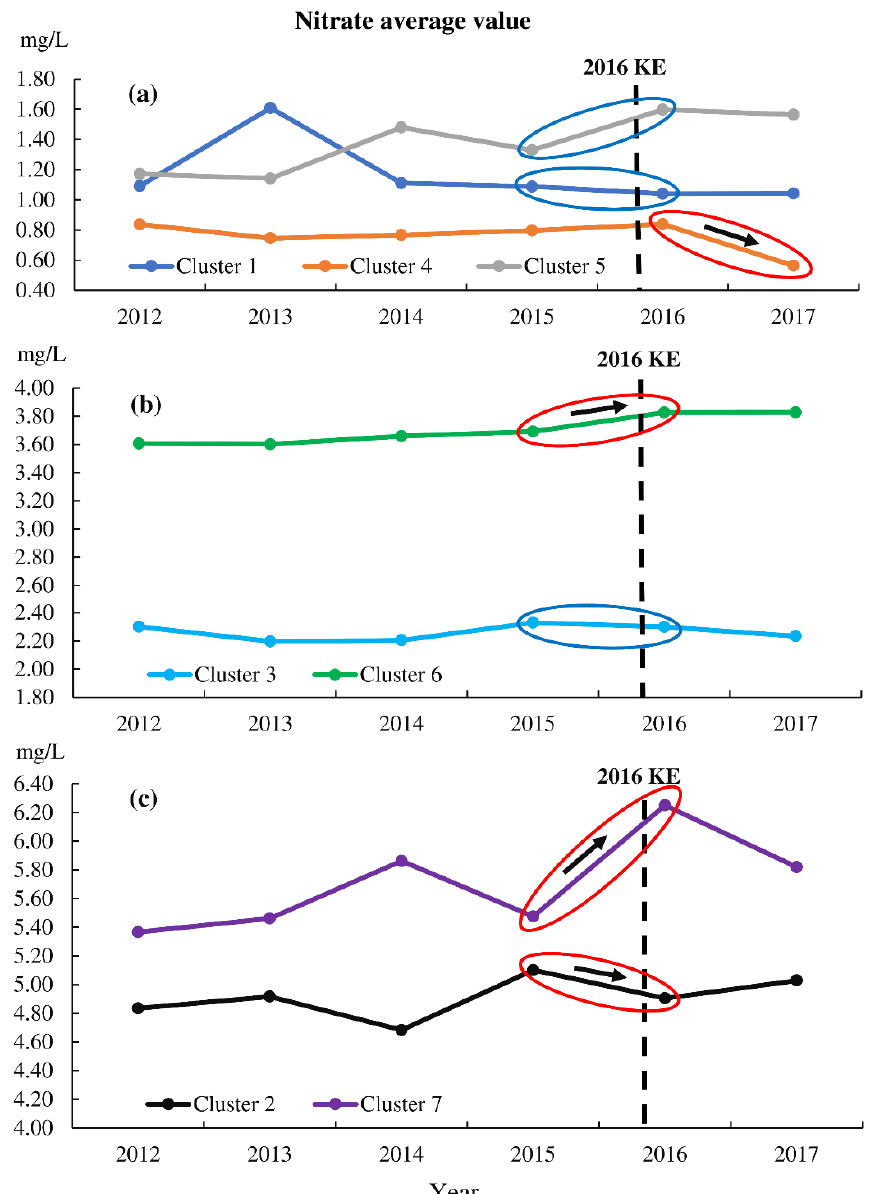
Figure 9. Pre- and post-seismic groundwater nitrate time-series ( a ) Nitrate change for lower groundwater nitrate contents including Cluster 1, 4, and 5. ( b ) Trend of intermediate groundwater nitrate content including Cluster 3 and 6. ( c ) Change of high groundwater nitrate content including Cluster 2 and 7.